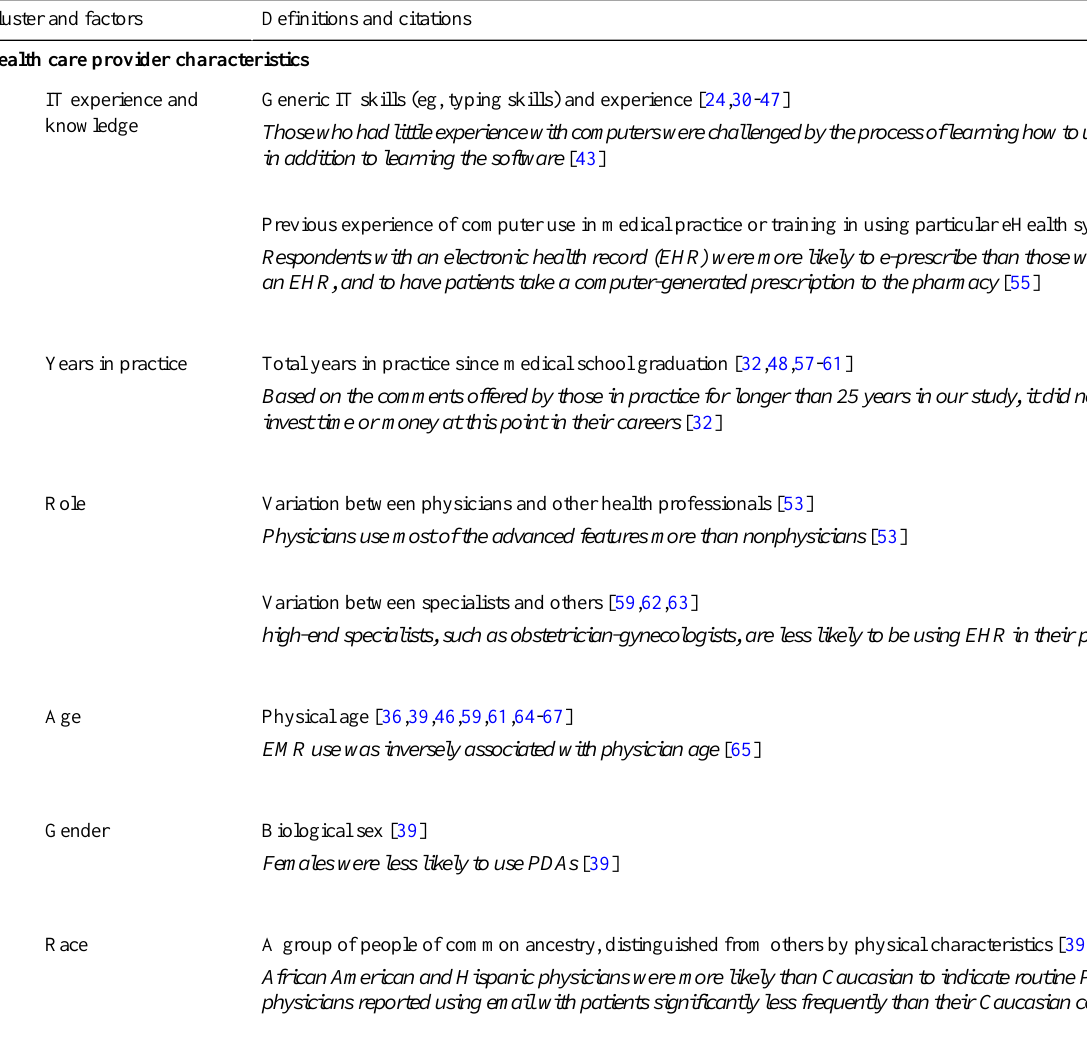
Table 2. eHealth acceptance factors under 7 clusters. Health care provider